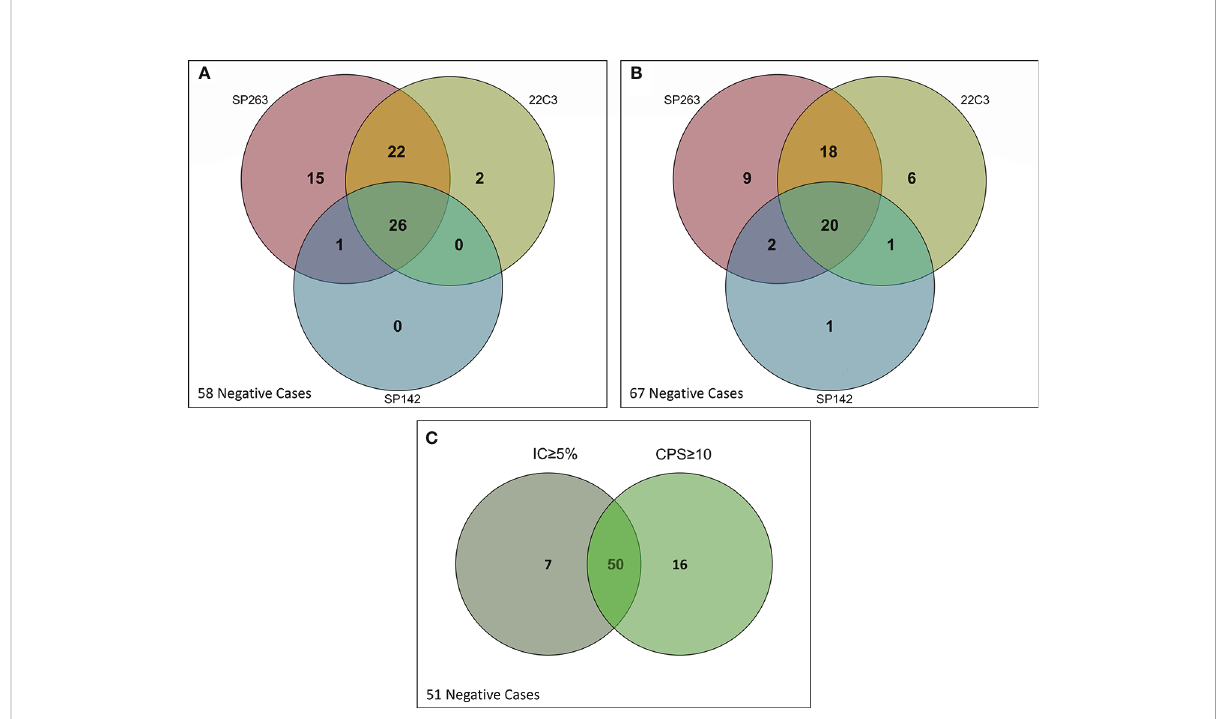
FIGURE 2 Venn diagrams showing positive and negative cases according to assays, clinical cutoffs and scoring algorithms. (A) CPS ≥ 10; (B) IC ≥ 5%; (C) CPS and